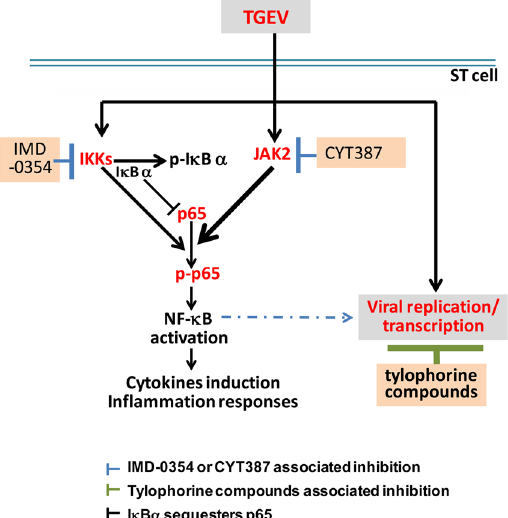
Figure 7. An illustrative scheme for effective points of tylophorine compounds, IMD-0354, and JAK inhibitor CYT387 in TGEV infected ST